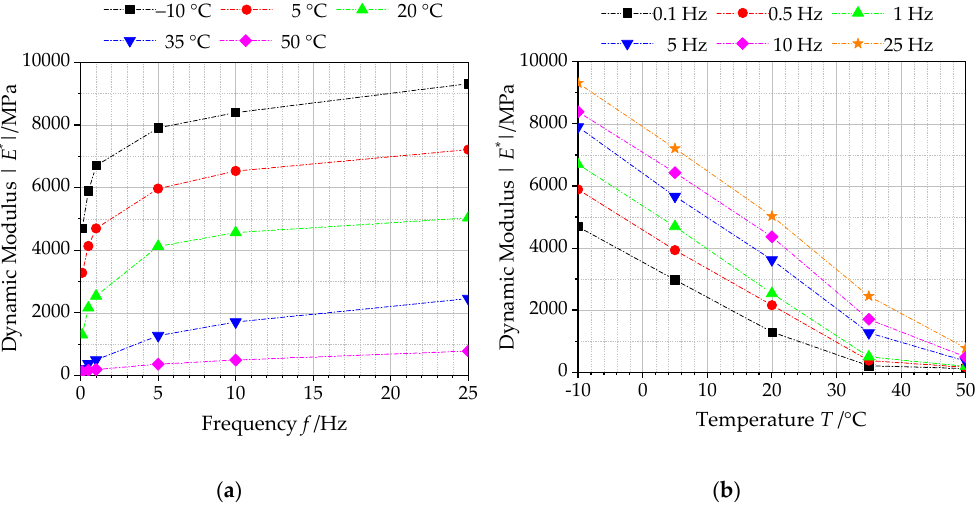
Figure 5. Dynamic modulus of asphalt mixtures with basalt fiber: ( a ) temperature, ( b ) frequency.